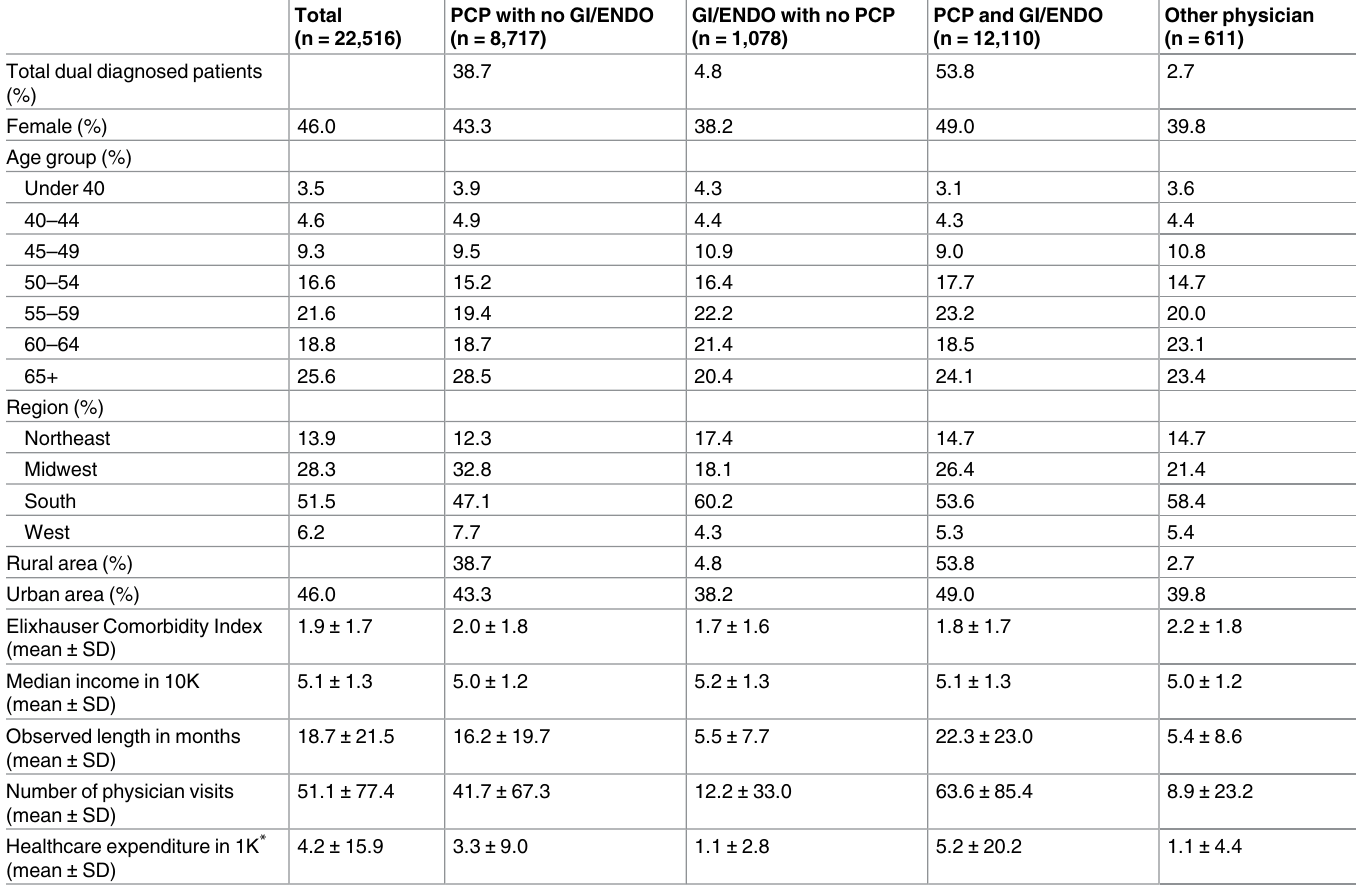
Table 1. Descriptivedistribution of patients who were dually diagnosed with compensated cirrhosis and diabetes by physician mix category, MarketScan 2000–2013. Total (n =